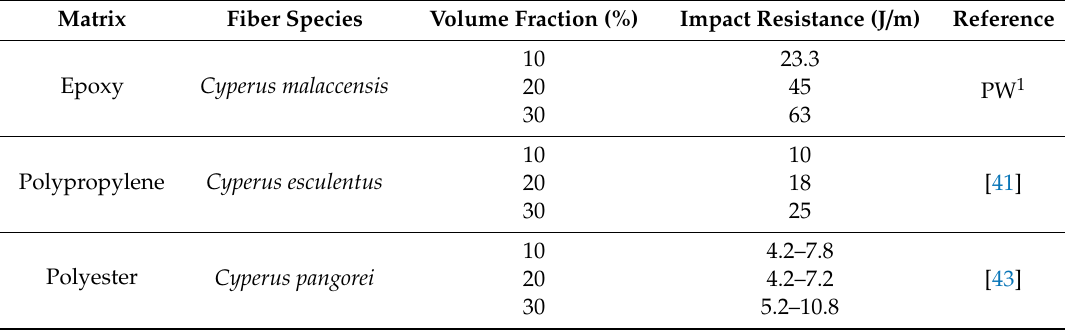
Table 4. Impact resistance comparison of composites reinforced with di ff erent natural fibers belonging to the Cyperus family.